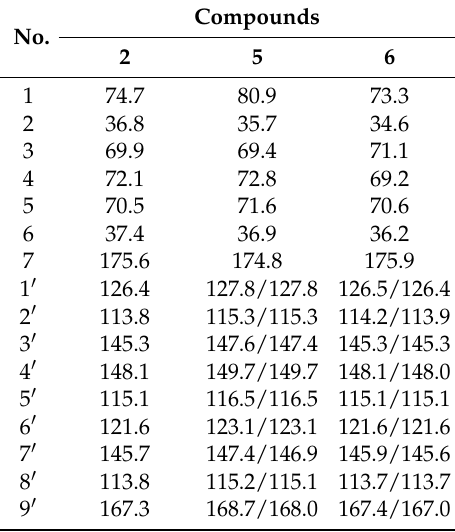
Table 2. 13 C-NMR Data for Compounds 2 , 5 – 6 (100 MHz, MeOH- d 4